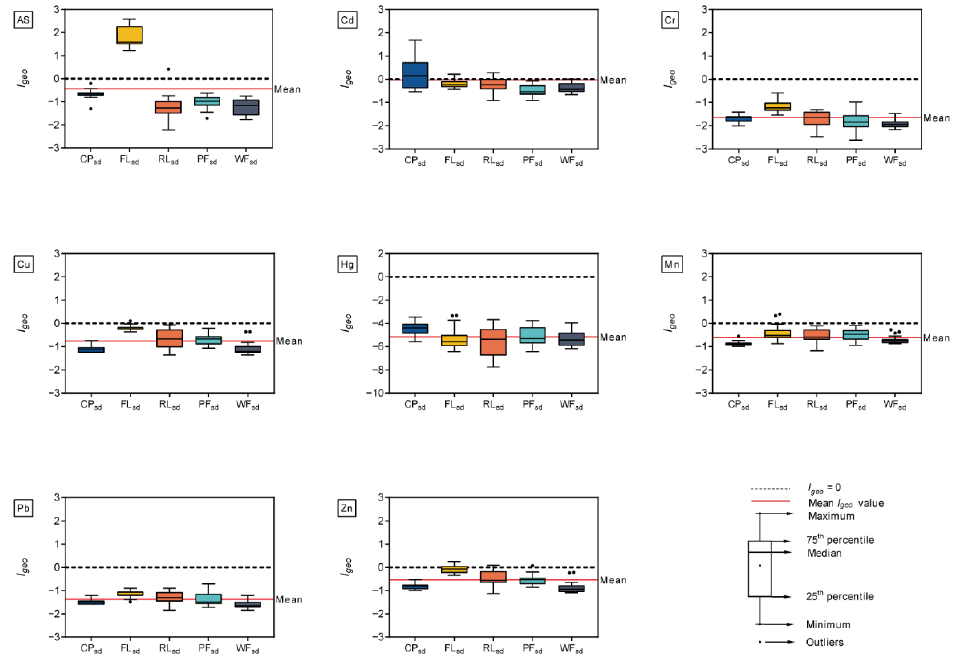
Figure 3. Box-plot of geo-accumulation index ( I geo ) of metals in the surface soil that were collected from CP sd, FL sd , RL sd , PF sd , and WF sd . The red solid line represents the mean I geo values that were averaged across all types of land use, and the black dashed line represents I geo = 0.